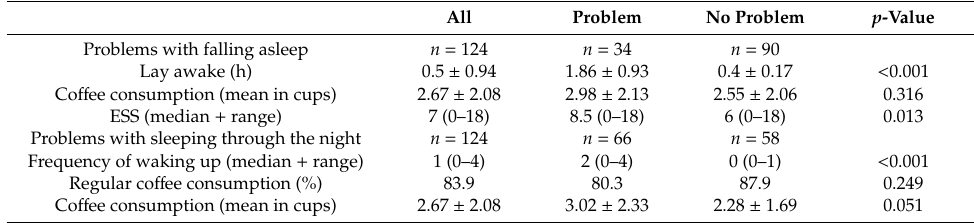
Table 4. Characteristics of patients with MS regarding sleep.